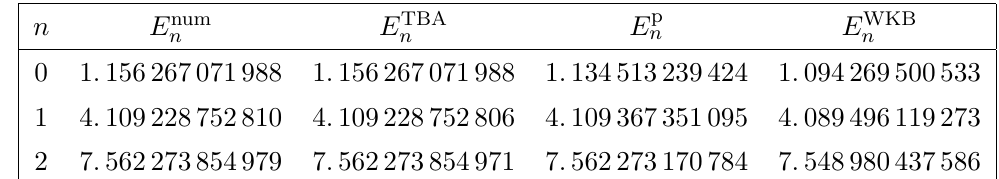
Table 3 . The energy levels for the PT cubic oscillator for ~ = p 2. The (cid:12)rst column shows a numerical calculation with complex dilatation techniques. The second column is a calculation by using the TBA system with L = 25 and n = 2 16 steps in the discretization. The third column is obtained by using the all-orders WKB perturbative quantization condition (4.12) and the TBA